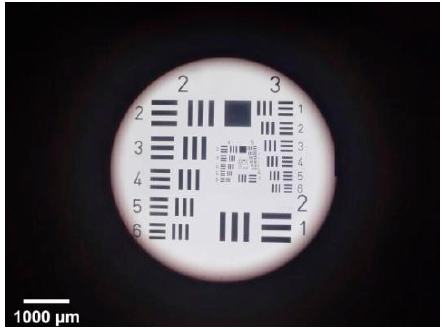
Figure 8. Picture of resolution test chart using P20pro tele ‐ photo lens (EFL = 8 mm). Theoretically, when the longer focal length lens is used as an objective lens, the magnification will be reduced and the FOV will become larger. In practice, the FOV may be limited to a smaller circle by the objective lens imaging angle limitation.